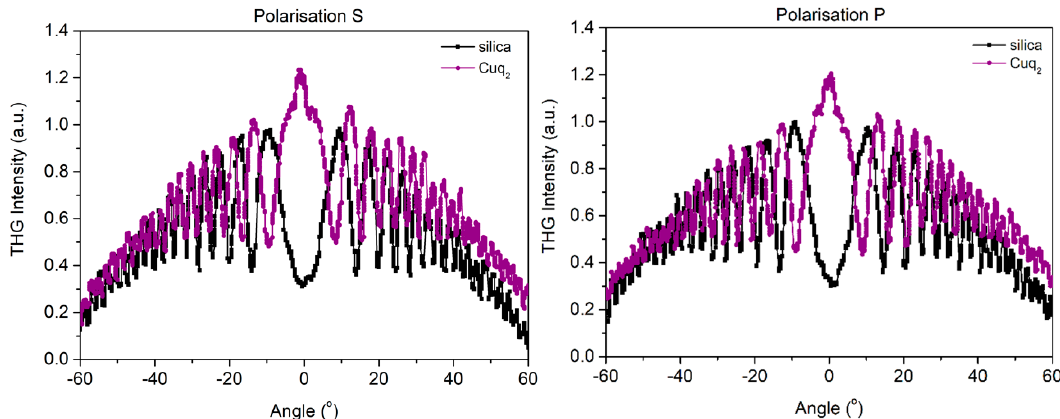
Figure 6. Third harmonic intensity of Cuq 2 film and silica as a function of the incident angle for polarization s and p.